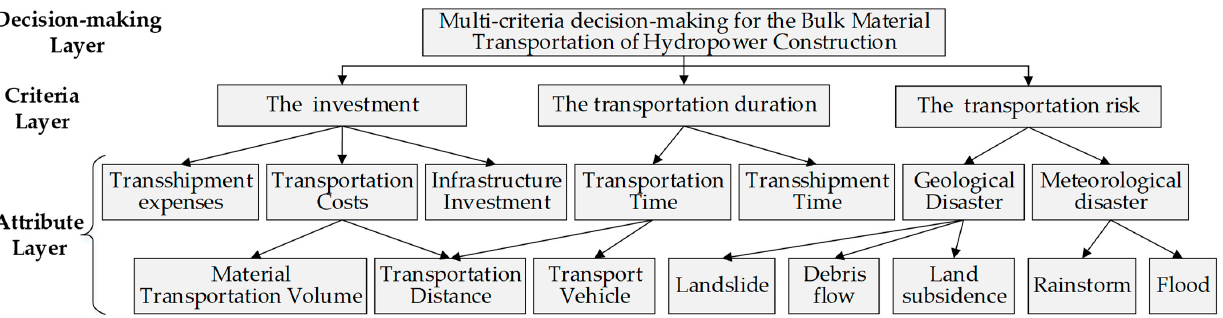
Figure 4. The hierarchical structure of the MCDM.